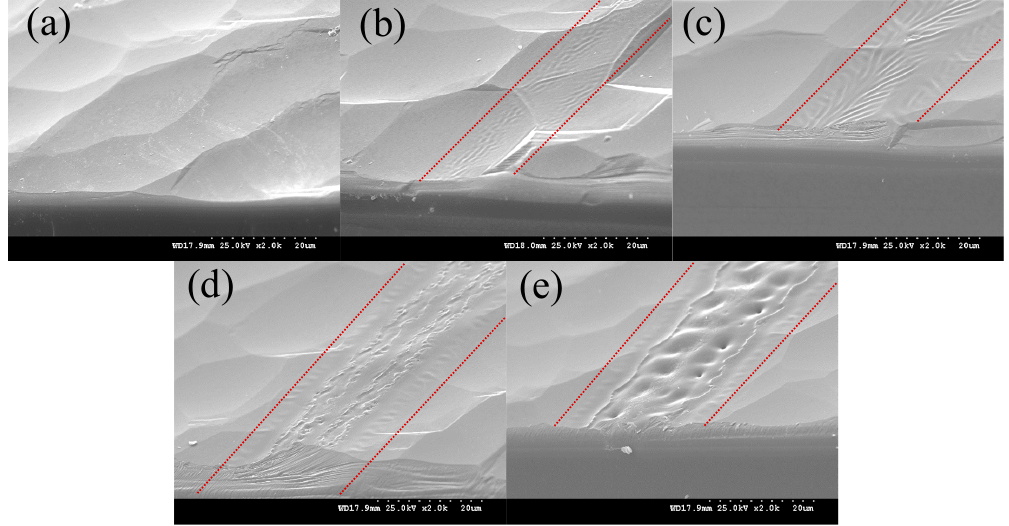
Figure 5. Cross-sectional images of the Si wafer versus laser fluence: ( a ) 0.3 J/cm 2 , ( b ) 0.8 J/cm 2 , ( c ) 1.29 J/cm 2 , ( d ) 1.77 J/cm 2 , and ( e ) 2.25 J/cm 2 .